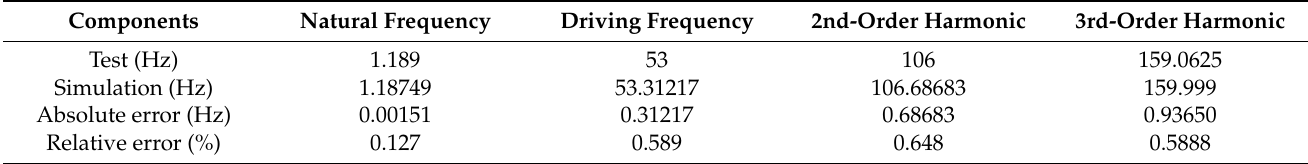
Table 5. Comparison of simulation/test frequencies.